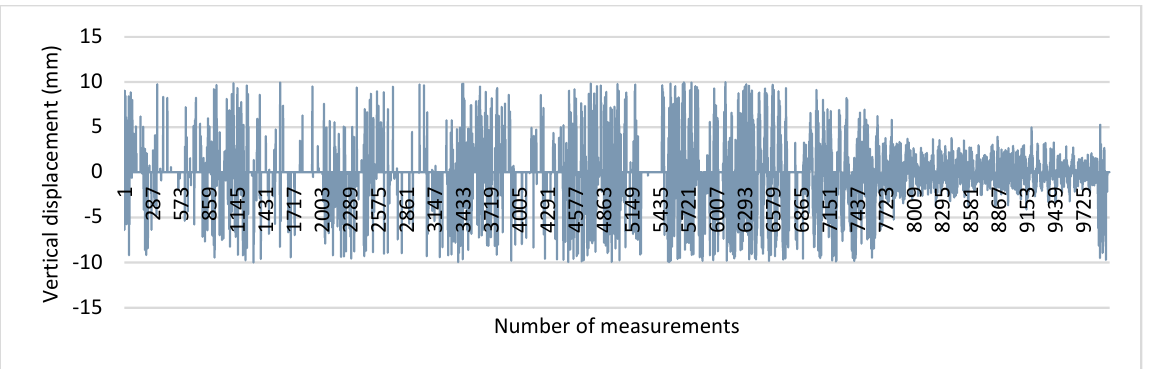
Figure 7. Results of a vertical displacement measurement with LDV Polytec PDV 100 for a passenger train in